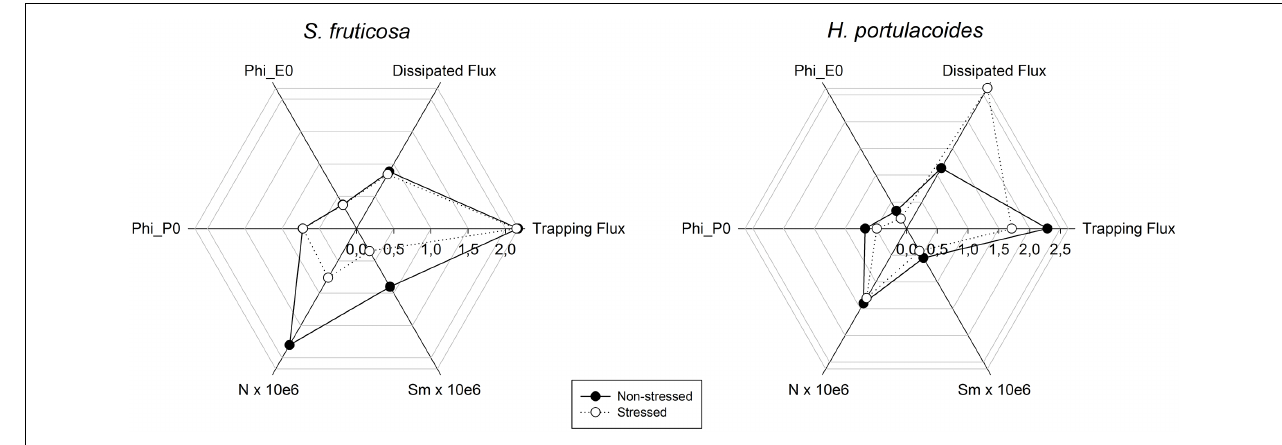
attained; Sm, the number of electrons that flow from the quinones to the ETC) radar plot in field stressed (white) and non-stressed individuals (black) of S. fruticosa and H. portulacoides species (average values, N = 5).